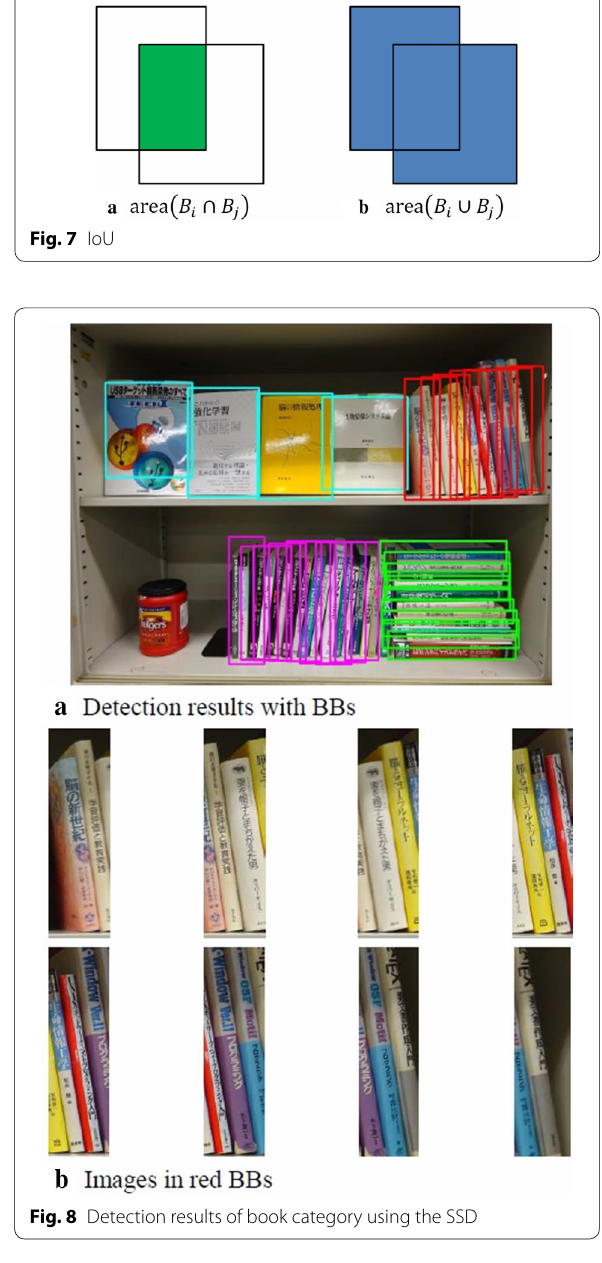
Fig. 8 Detection results of book category using the SSD